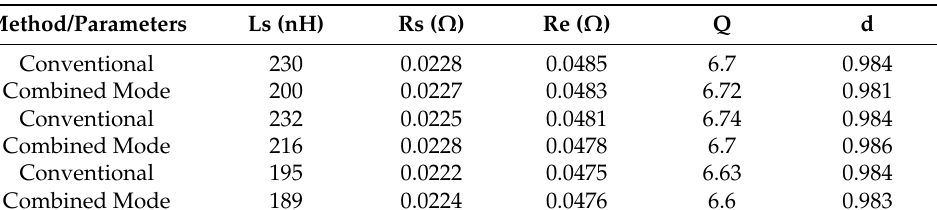
Table 1. Comparisons of the parameters of samples A, B and C obtained by the proposed method and WEIS500 workstation.